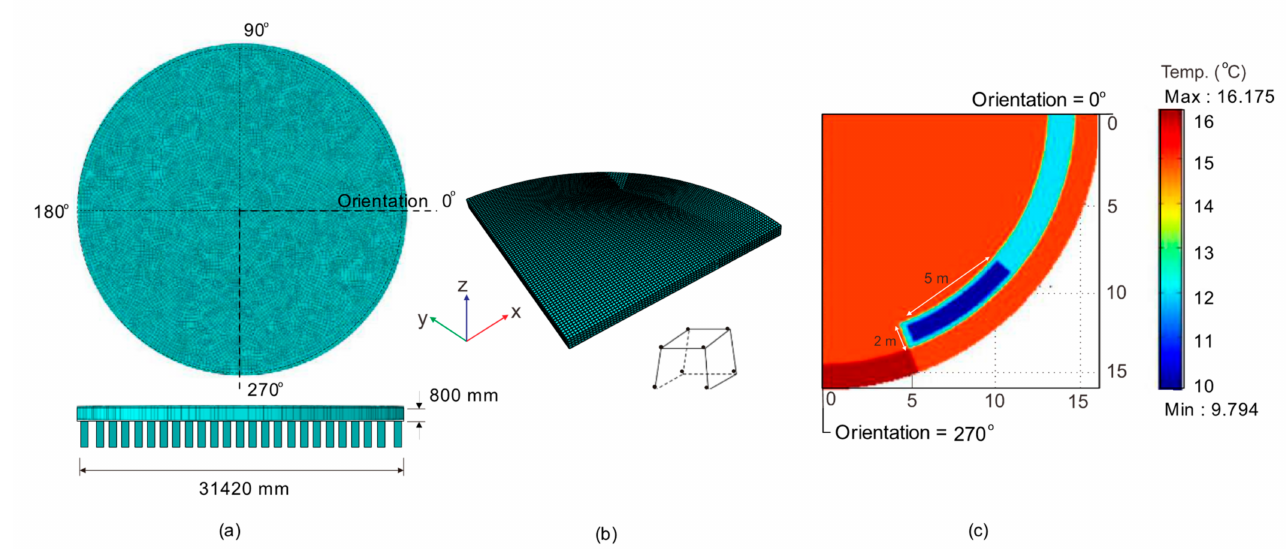
Figure 5. ( a ) Plan view and cross section of 3D FE mesh of the slab; ( b ) Close-up view of mesh for quarter of slab, and ( c ) quarter of slab showing the thermal boundary